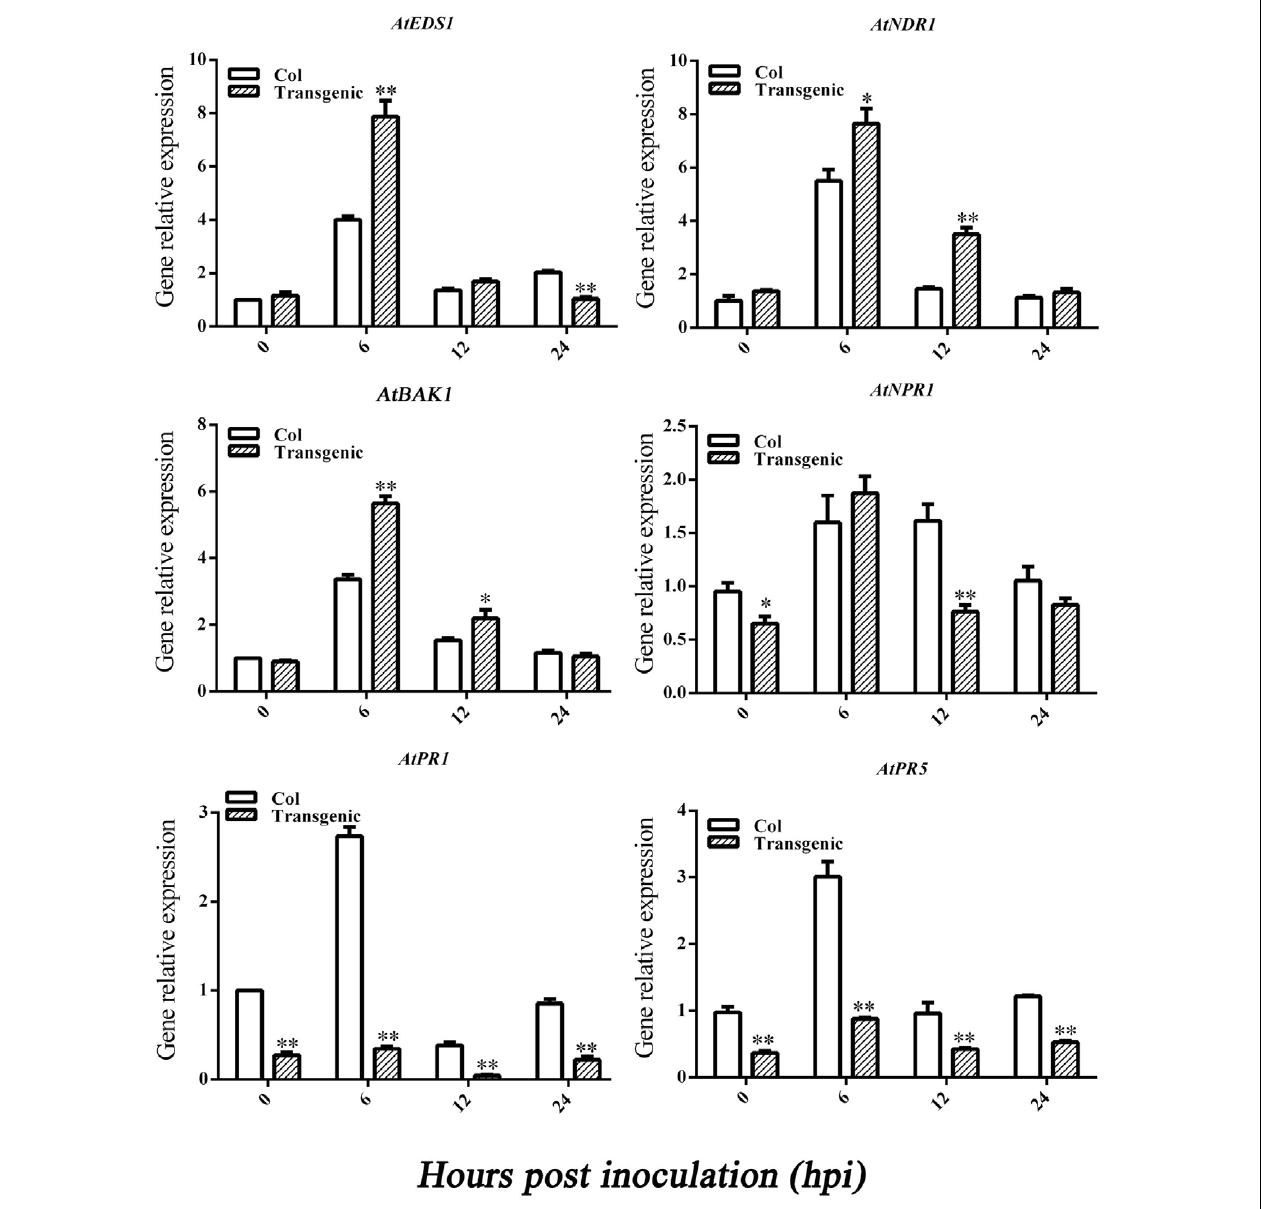
FIGURE 8 | Detection of SA signaling pathway-related genes and defense related genes. qRT-PCR analysis the expression of genes ( EDS1 , NPR1 , NDR1 , BAK1 , PR1 , and PR5 ) in transgenic plants. Error bars represent the standard deviation for three independent experiments, and three technical replicates were analyzed; asterisks indicate statistically significant differences, as determined by the Student’s t -test ( ∗ P < 0.05, ∗∗ P < 0.01).